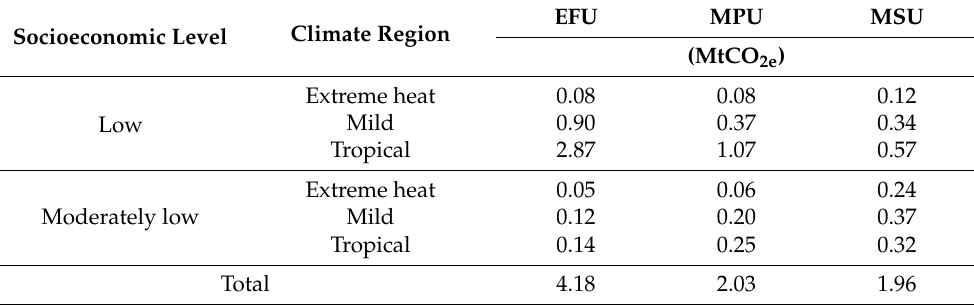
Table 7. Total GHG emissions resulting from consumption of firewood by EFU, MPU, and MSU. EFU MPU MSU Socioeconomic Level Climate Region (MtCO 2e ) Extreme heat 0.08 Mild 0.90 0.37 Low Tropical 2.87 Extreme heat Moderately low